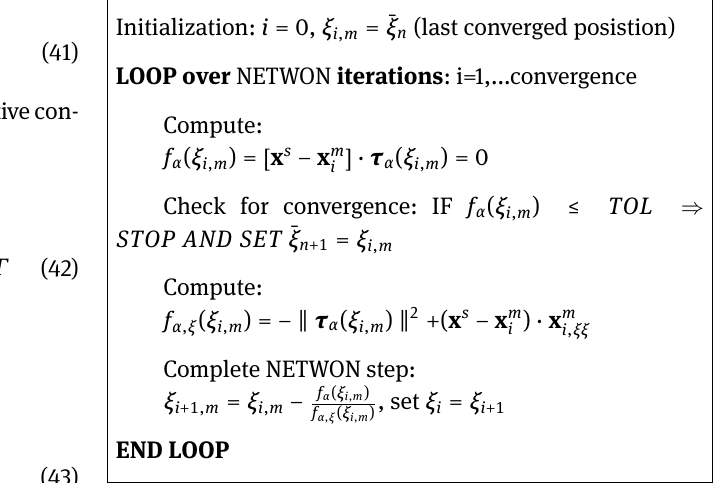
Initialization: i = 0, ξ LOOP over NETWON iterations :